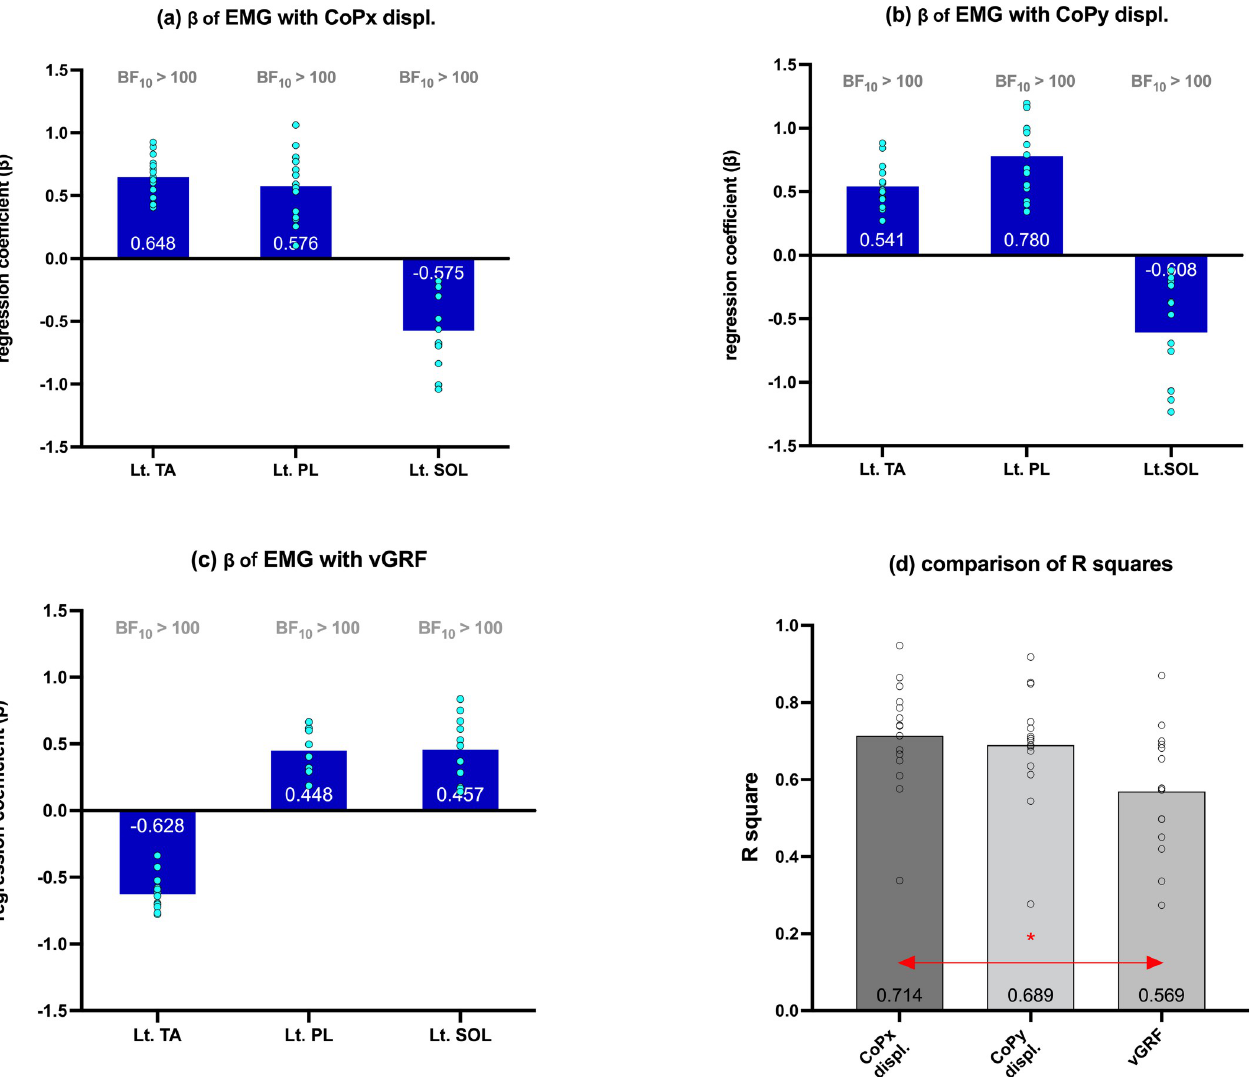
Fig 6. Standardized regression coefficients ( β ) of EMG_Lt.PL, EMG_Lt.TA, and EMG_Lt.SOL with (a) foot CoPx displacement, (b) foot CoPy displacement, and (c) vGRF during the left push phase. The box height represents the mean value, and the circles represent individual data points. The Bayes factors (BF 10 ) indicate the evidence level that the regression coefficients are different from zero. (d) R 2 of the three dependent variables Red arrow with ( � ) shows the significantly different pair on ANOVA post-hoc comparison (p < 0.05 Tukey). Numbers in the box represent the mean values of the variable.